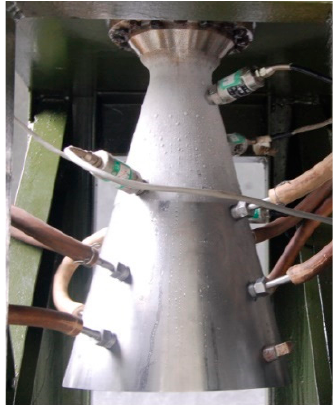
Figure 4. Space face of the nozzle during the test of the nozzle.